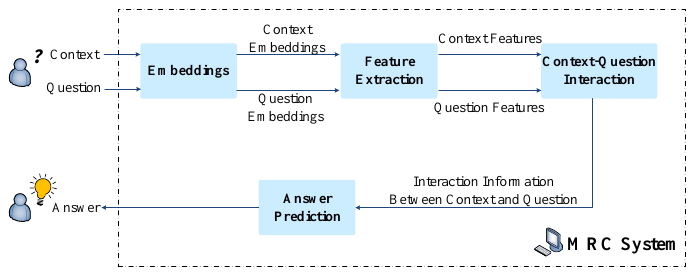
Figure 5. The general architecture of machine reading comprehension